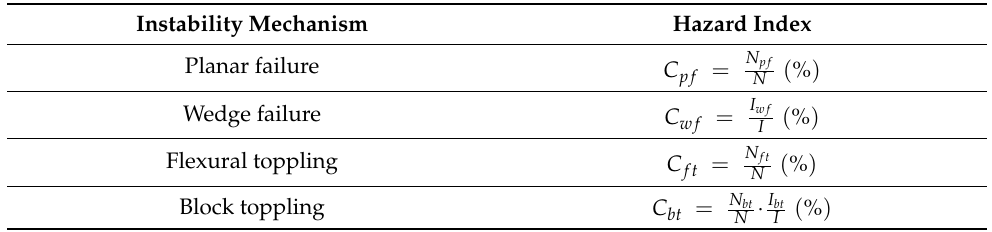
Table 3. Hazard kinematic indexes [49], N = number of poles satisfying a specific failure condition; I = number of intersections satisfying a specific failure condition.